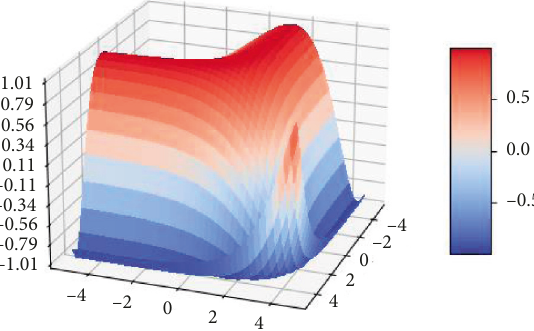
Figure 8: The complexity of grammar